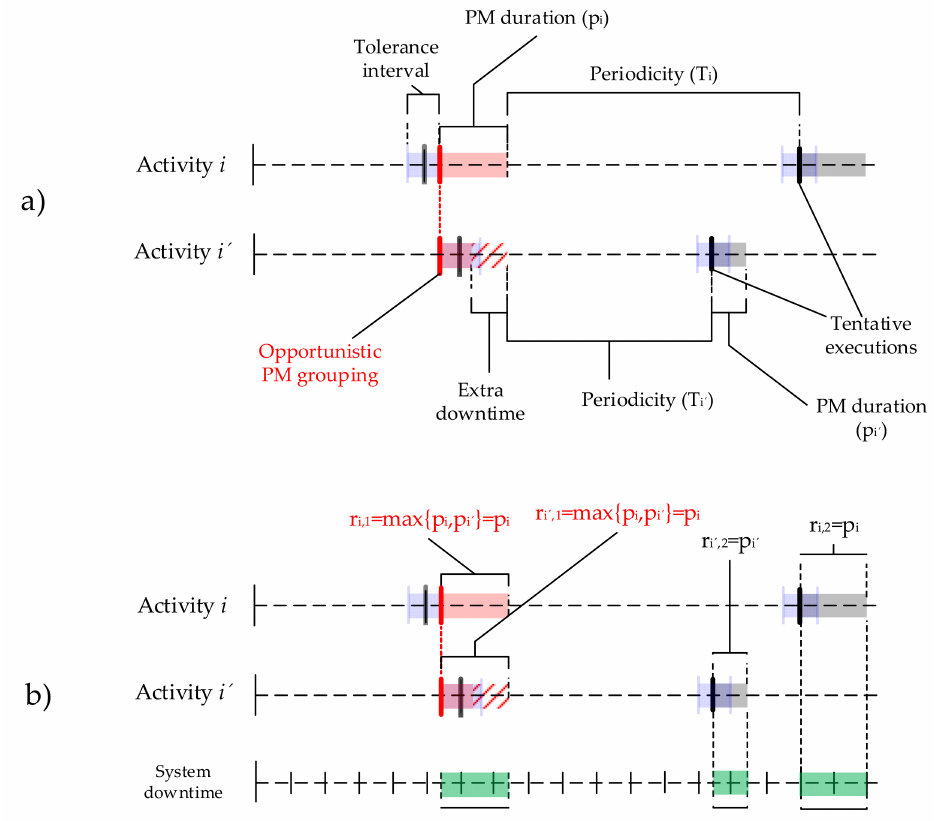
Figure 3. ( a ) Impact of the grouping strategy on the periodicity and tentative executions; ( b ) impact of grouping schemes over the system